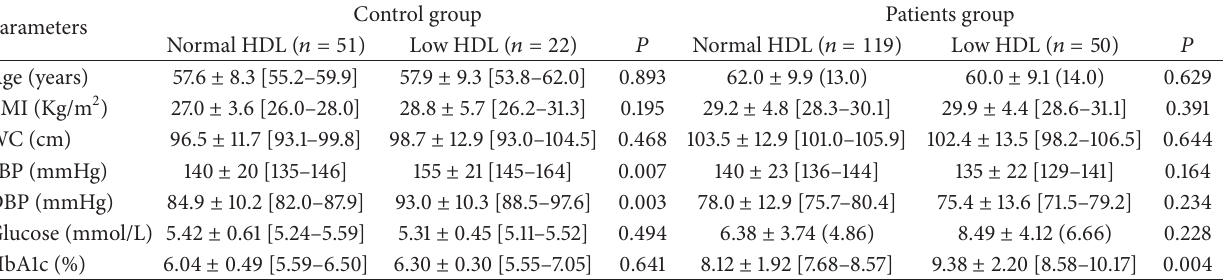
Table 1: Anthropometric data and general characterization of the study groups.